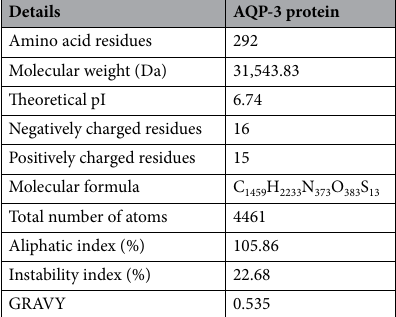
Table 2. Summary of physicochemical properties of AQP-3 protein determined by the ExPASy ProtParam program.